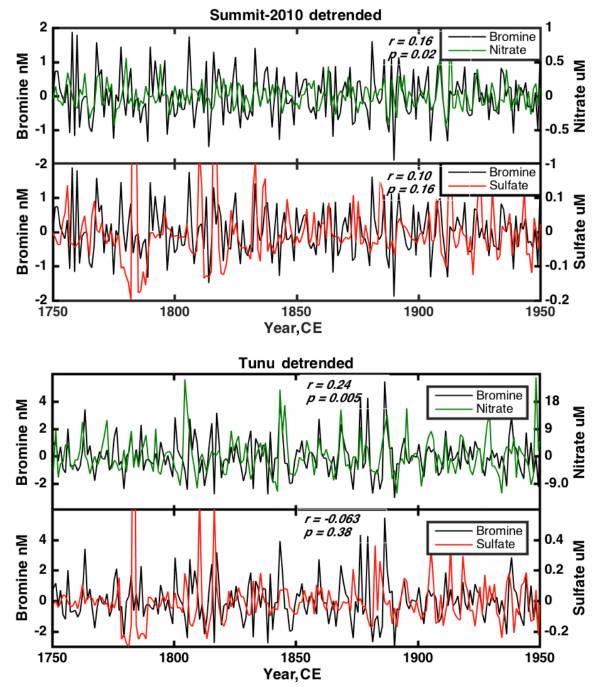
Figure 9. High-frequency comparison between the annual bromine, nitrate and sulfate records measured in the ice cores. Each series has been detrended with an 11-year running average before com- parison to remove the low-frequency changes in each record. The correlation is highest between bromine and nitrate at both sites. The r value for bromine vs. nitrate at Summit increases in significance ( r = 0 . 24, p = 0 . 001) when the entire period (1750–2010) is con- sidered. At both sites there is a close relationship between the vari- ability in the nitrate and bromine due to their intimate relationship during emission from the sea ice, transport and deposition onto the snowpack. The correlation between sulfate (or indeed bulk acidity) and bromine is not significant over any of the time periods shown at either site. Particularly evident is the non-response of the bromine signal to the sulfur rich volcanic events as described in Sect.